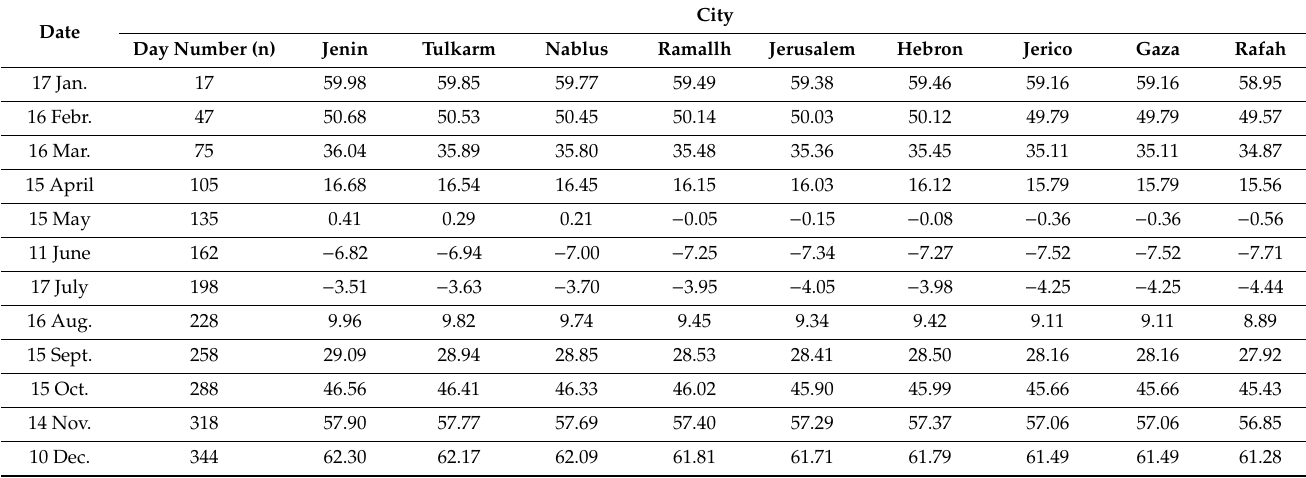
Table 3. The daily optimum tilt angle β opt,d for recommended average days of months for the main Palestinian